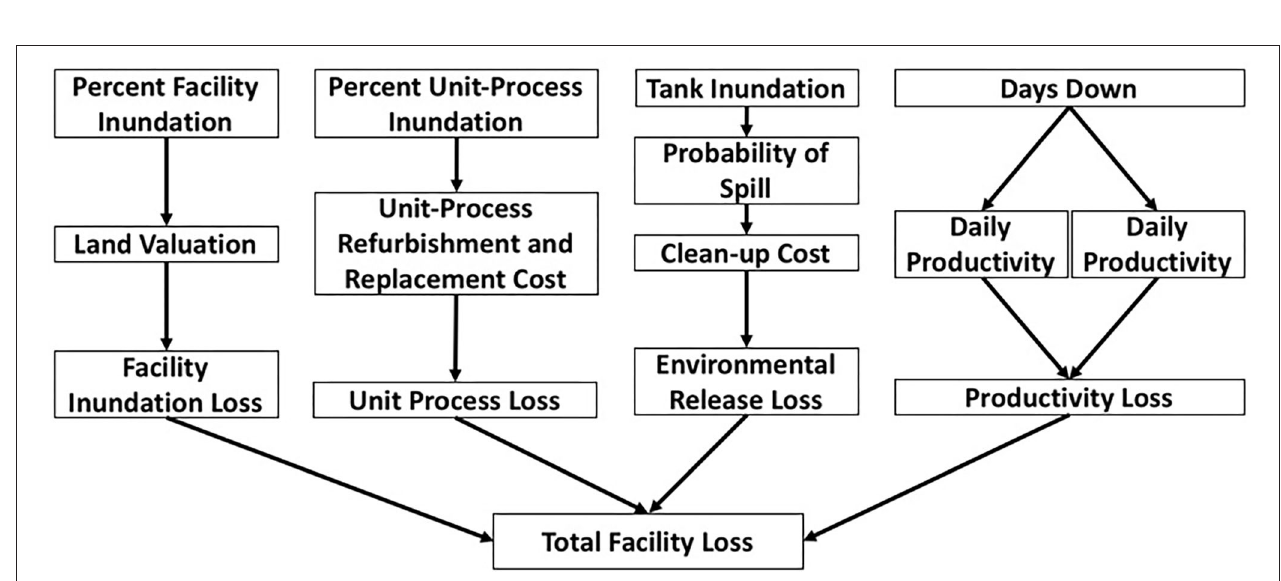
FIGURE 4 | The FEDERAP model